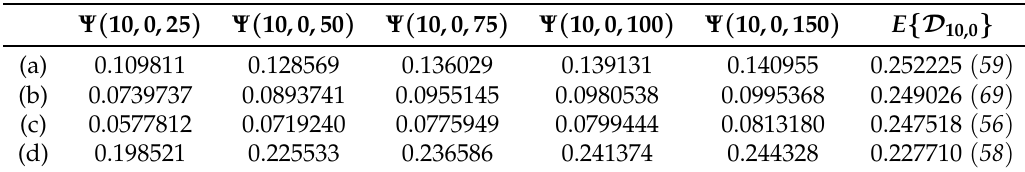
Table 4. Finite-time ruin probabilities and expected total discounted dividends paid prior to ruin when